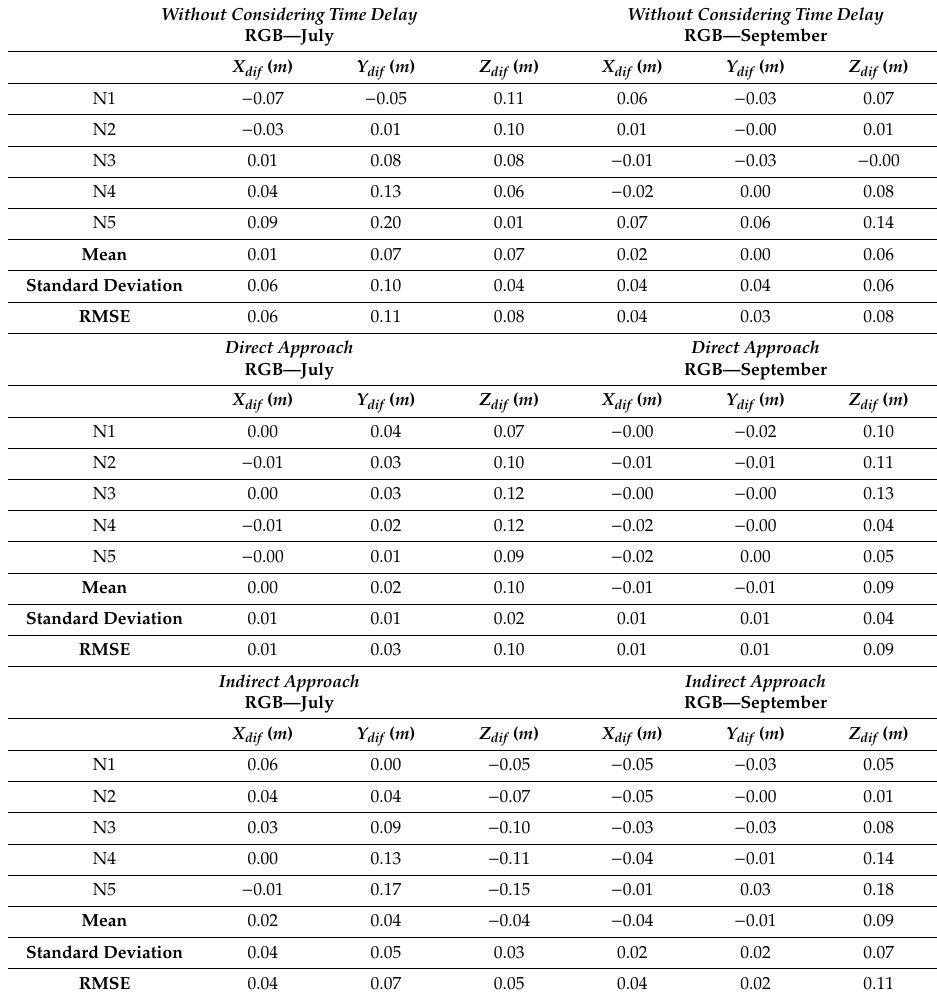
Table 11. Components and mean / standard deviation / RMSE of the di ff erences between check point and surveyed coordinates for the five check points for the DJI M200 RGB platform.